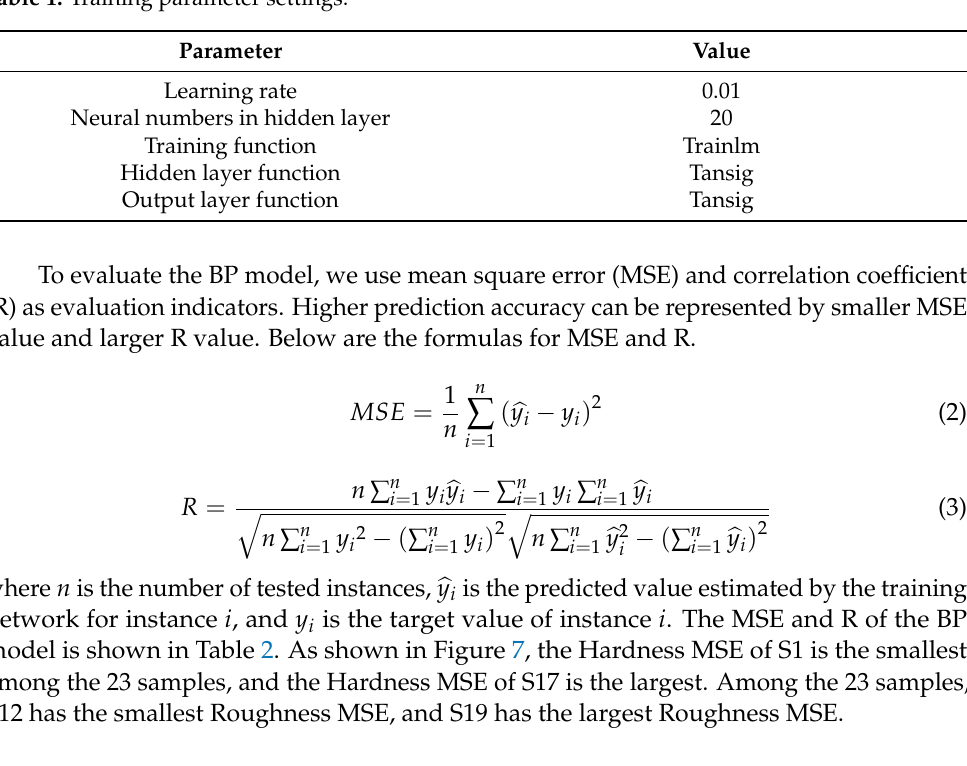
Table 2. Evaluation indicators of BP